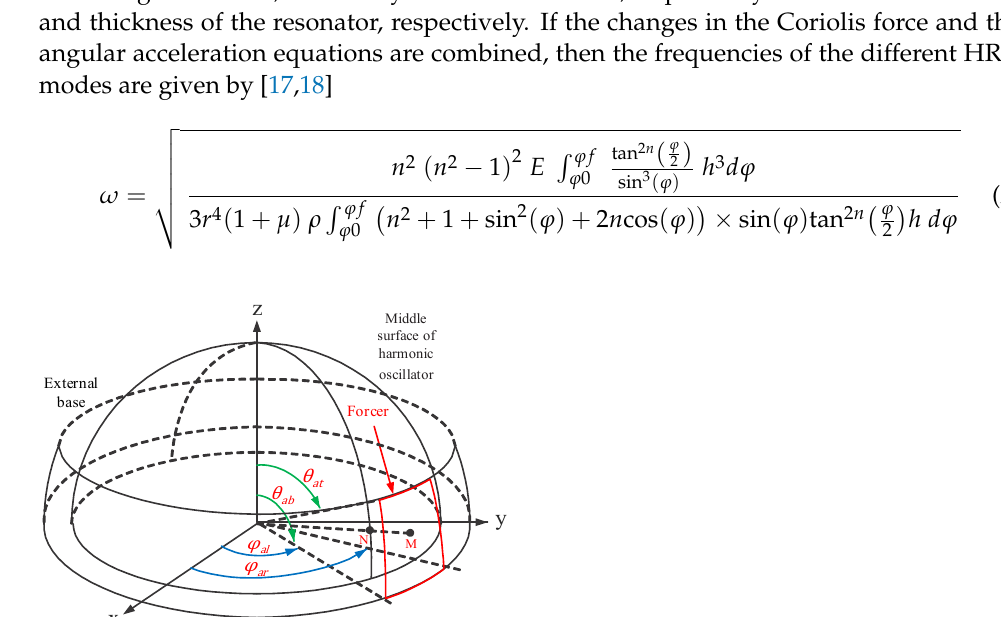
Figure 3. Linear movements of the proof mass.